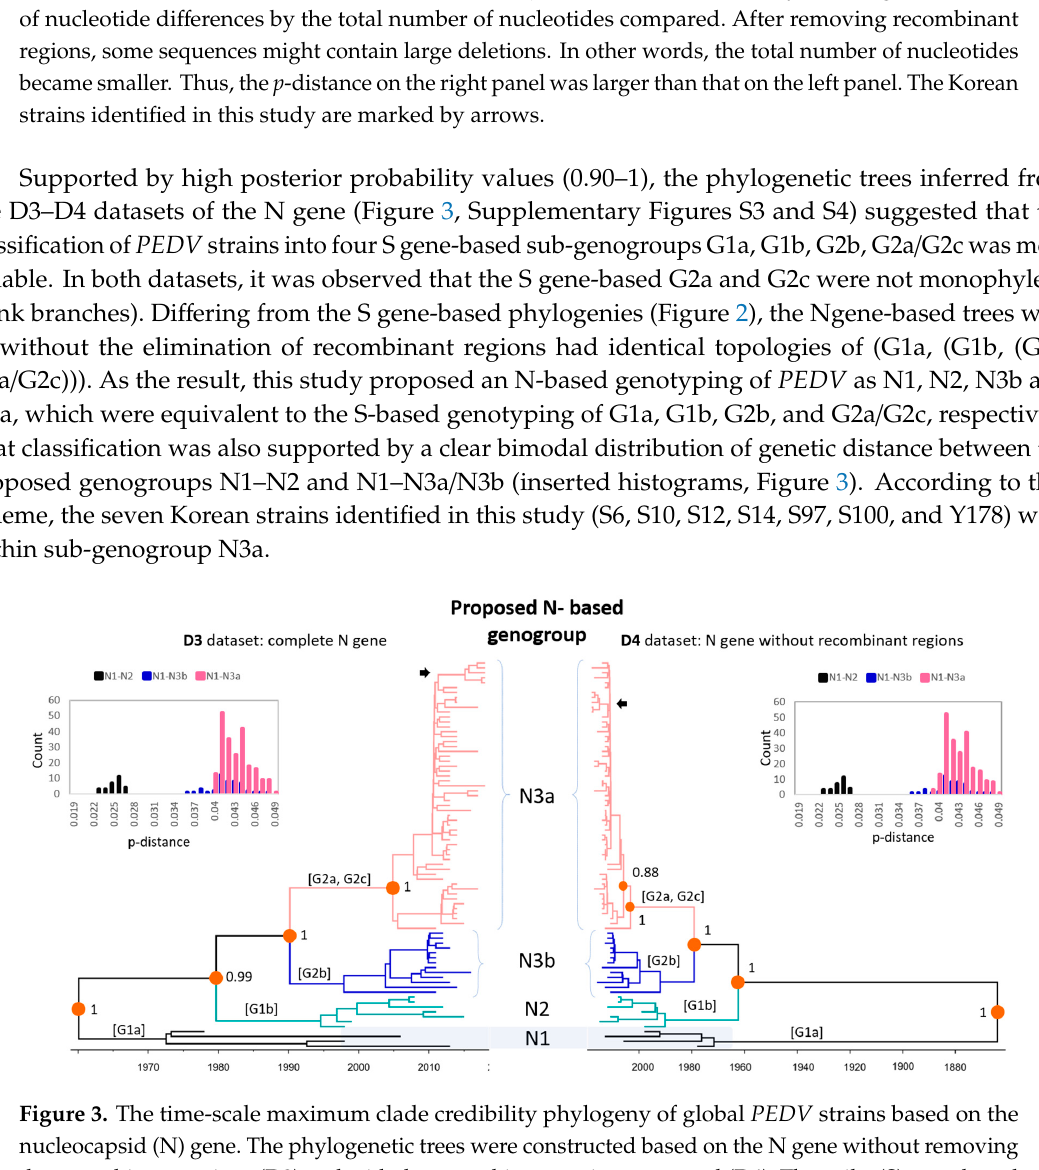
Table 3. Estimated nucleotide substitution rates for the S and N genes.